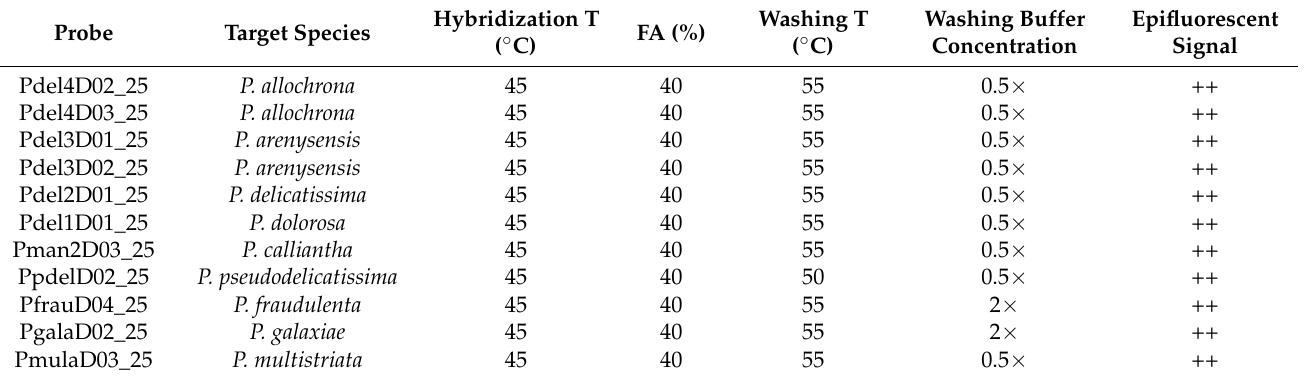
Table 2. Probes testing and WC-FISH optimisation. The table shows hybridization temperature, formamide concentration (FA), temperature, and concentration of post-hybridization buffer and epifluorescent signal. Cells with signal intensity similar to the positive control were scored as ‘++’. Hybridization T Washing T Washing Buffer Epifluorescent Probe Target Species FA (%) ( ◦ C) ( ◦ C) Concentration